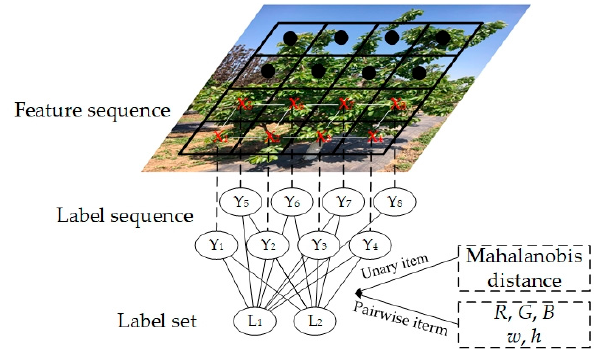
Figure 8. The CRF operation chart. X is the feature sequence, Y is the label sequence, L1 indicates the tree-crown class, and L2 indicates the background class. R , G and B are the red, green and blue channels in RGB color space; w and h represent the vertical and horizontal coordinate of the image, respectively.